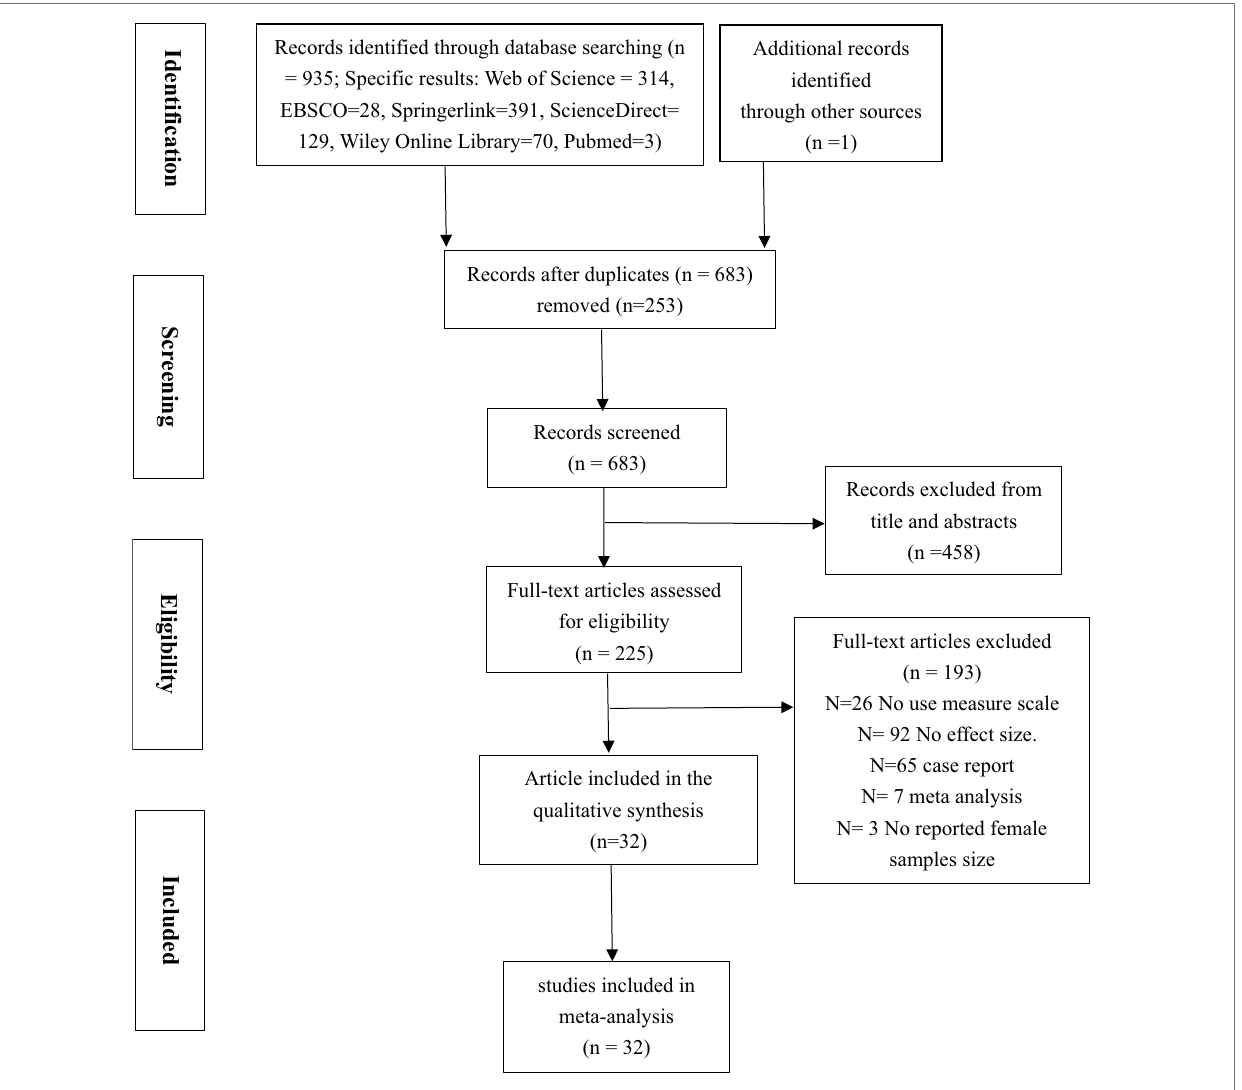
FIGURE 1 | PRISMA flow chart diagram showing the process of study selection for inclusion in the systematic review on moral disengagement and